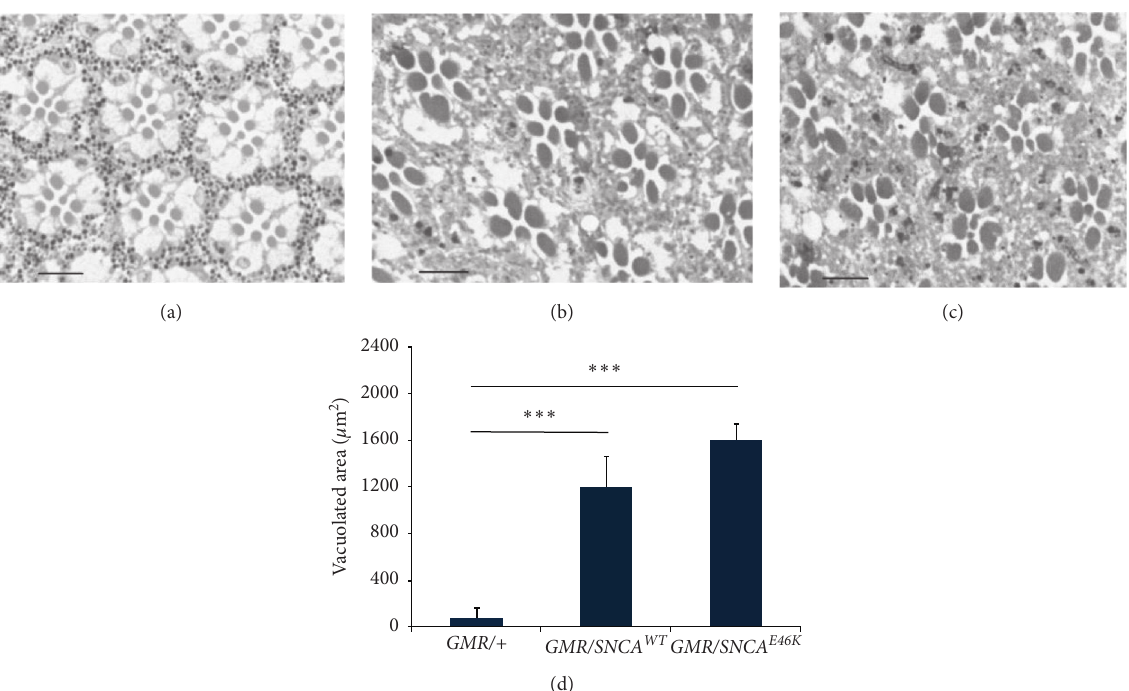
Figure 3: Retinal neuron degeneration in human SNCA transgenic flies. Photomicrographs of apical tangential sections of ommatidia in E46K α -synuclein transgenic flies show disorganized photoreceptor cells, vacuoles, and neurodegeneration (1000x magnification, toluidine blue-stained). (a) GMR/+ , (b) GMR/SNCA WT , and (c) GMR/SNCA E46K . (d) Measuring total vacuolated area approves that degree of degeneration in SNCA E46K flies is remarkably higher than observed in the SNCA WT genotype ( ∗∗∗ p < 0 . 001; by t -test; n � 15). Scale bar, 10 μ